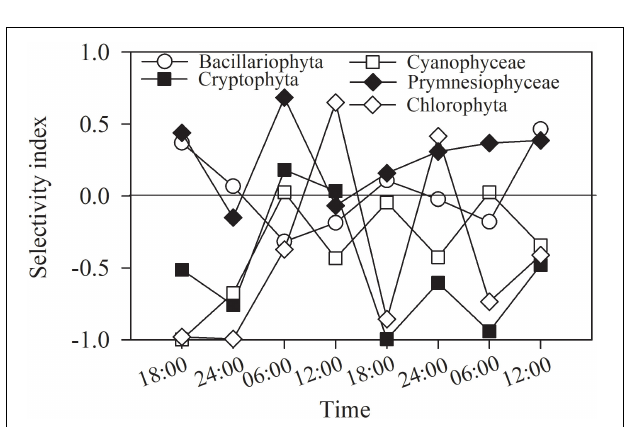
the upper and bottom layer reached 1.2 and 0.9 ◦ C at daytime